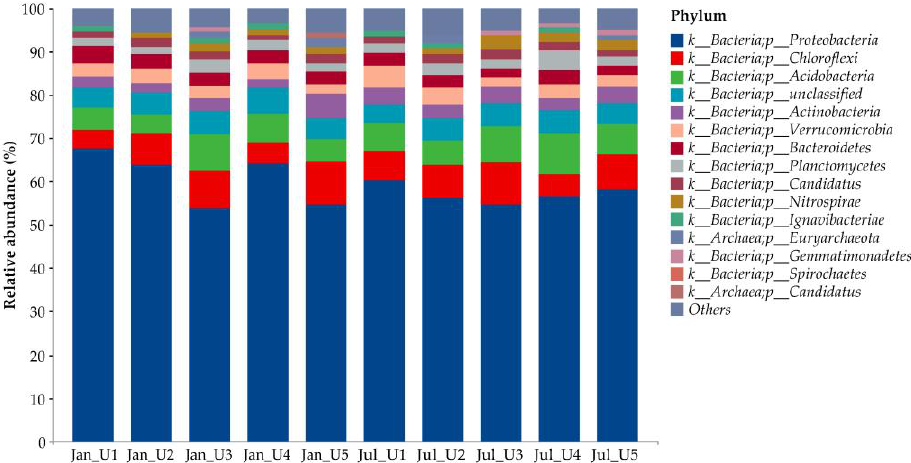
Figure 3. Histogram of nitrogen-associated microbial community composition and relative abundance at the phylum level.